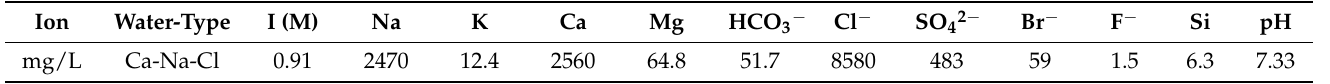
Figure 2. Temperatures profiles as a function of the heater contact (0, 5, 40 and 60 mm) measured